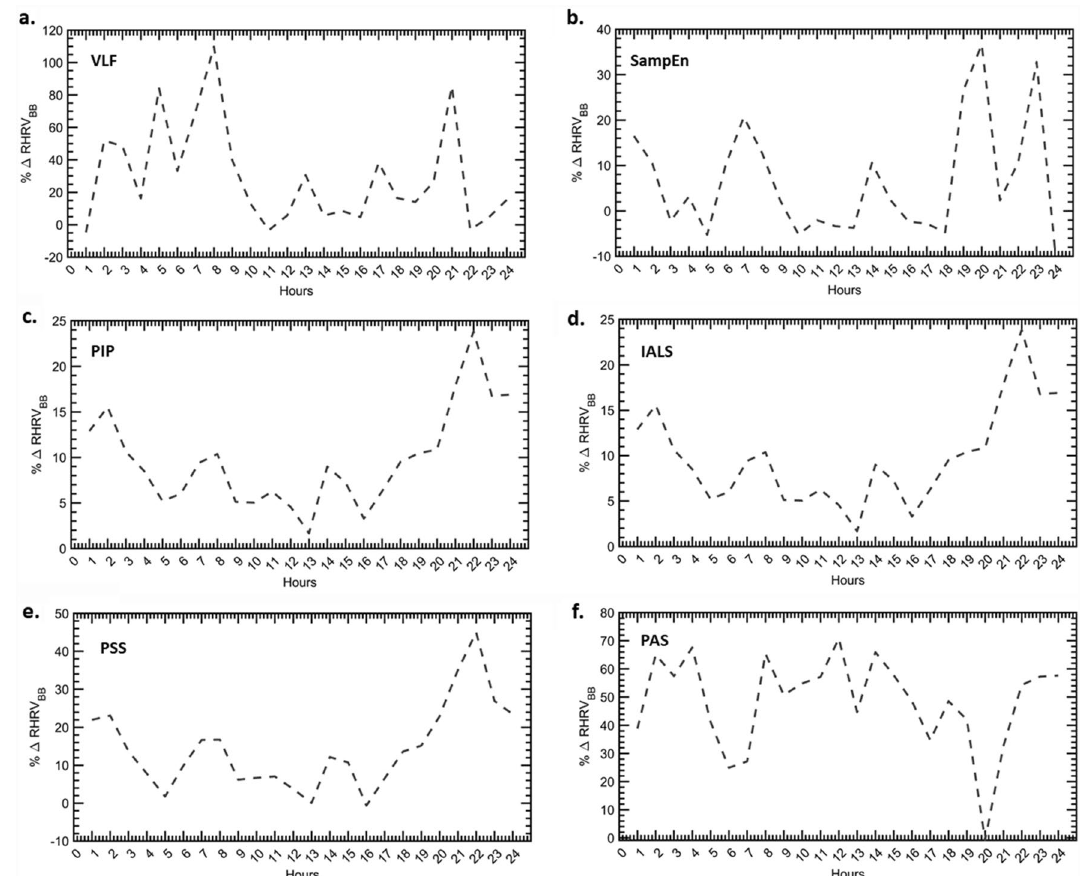
Figure 4. The relative percentage change in HRV features of the BB group relative to NBB for non-linear and fragmentation measures. ( a ) VLF. ( b ) Sample entropy. ( c ) PIP. ( d ) IALS. ( e ) PSS. ( f ) PAS.